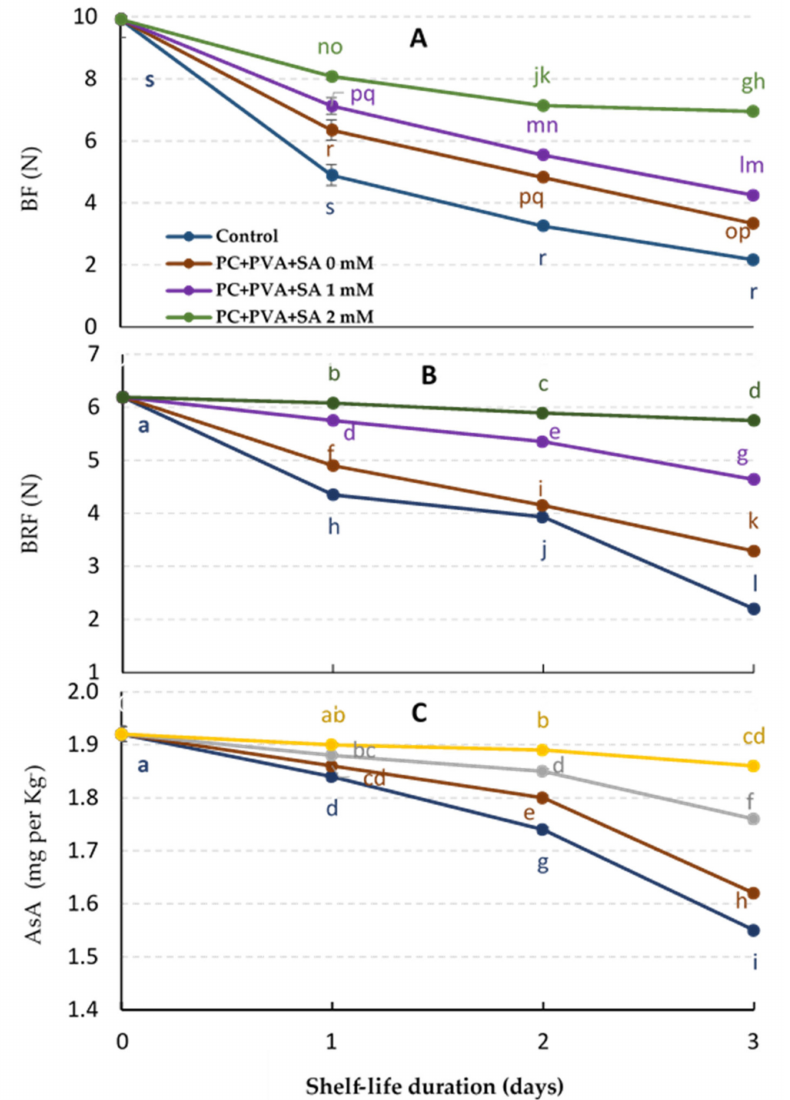
Figure 4. BF ( A ), BRF ( B ), and AA ( C ) of ‘Crimson seedless’ grapes coated with PE + PVA blending with SA at different concentrations (0, 1, and 2 mmol L − 1 ) and stored at room temperature (26 ± 1 ◦ C and 65 ± 5% RH) for 3 d. Each value represents a mean of three replicates, with error bars representing standard errors ( ± SE), and different letters indicate significant differences at p ≤ 0.05 between treatments. Mean comparisons were performed between all